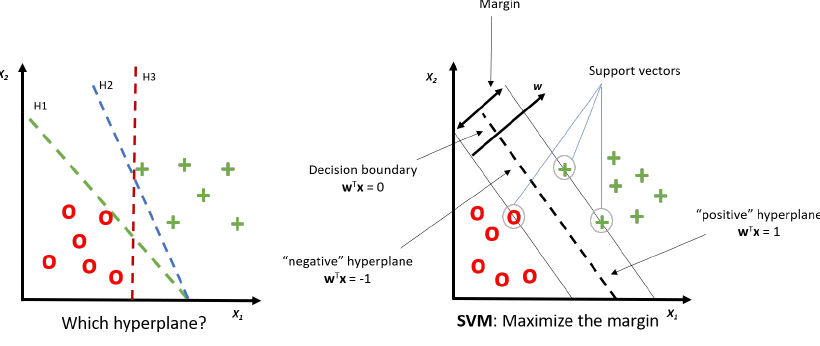
Figure 3. Demonstration of Support Vector Machine